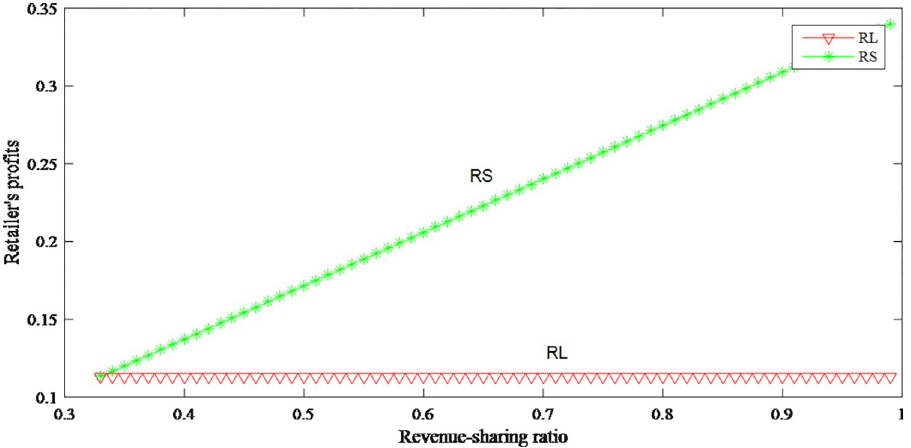
Fig 26. The impact of revenue-sharing contract on the retailer’s profits.